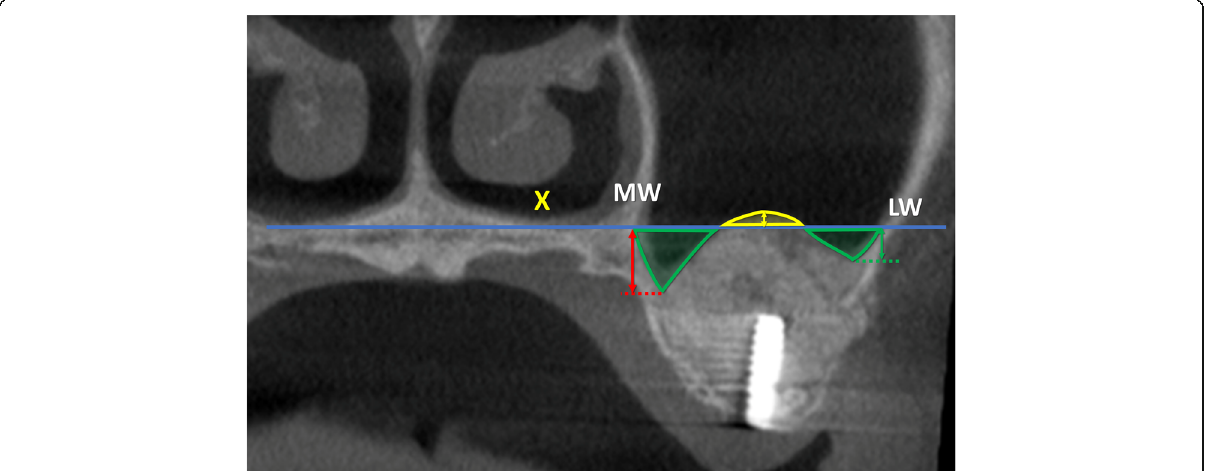
Fig. 4 T2, coronal view of a no-membrane CBCT; X, line drawn following the floor of the nose; MW, medial wall of the sinus; LW, lateral wall of the sinus; Exceeding area (bordered in yellow), area above the line X filled with biomaterial/ bone tissue. Residual areas (bordered in green),